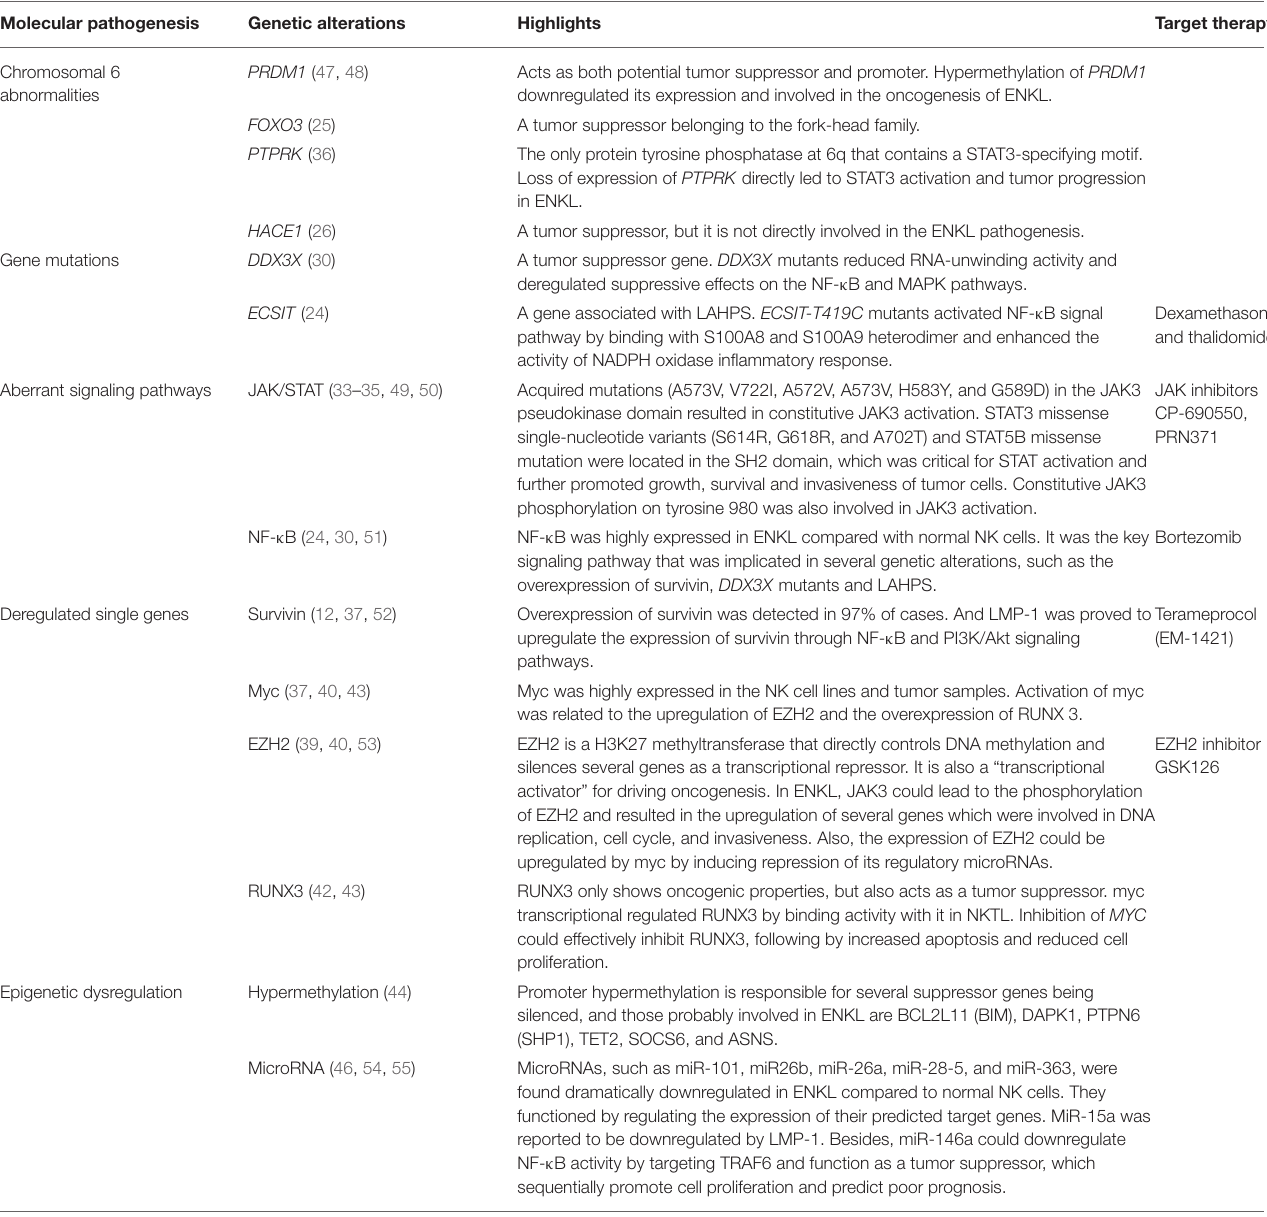
TABLE 1 | Molecular pathogenesis of Epstein-Barr virus-positive NK/T-cell